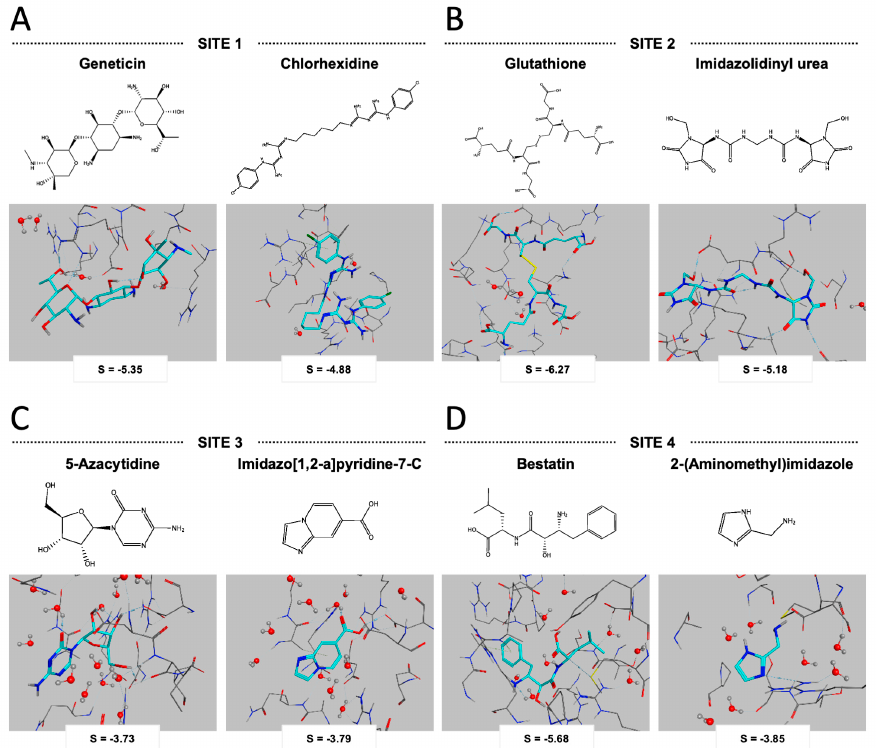
Figure 3. Molecular docking of small molecules into the potential inhibitor target sites of EC-LigA. The lowest energy EC-LigA-small molecule complexes for ( A ) geneticin and chlorhexidine docked into Site 1 ( B ) glutathione and imidazolidinyl urea docked into Site 2 ( C ) 5-azacytidine and imidazo[1,2-a]pyridine-7-C docked into Site 3 and ( D ) bestatin and 2-(aminomethyl)imidazole docked into Site 4. Small molecules are shown as cyan sticks with nitrogen coloured blue and oxygen coloured red. Amino acids in the potential inhibitor target site are shown as grey sticks with nitrogen coloured blue and oxygen coloured red. H 2 O molecules are shown as balls (oxygen, red; hydrogen, grey) and sticks. The docking score (S) for the complex, and the chemical structure of the small molecule, are also provided.